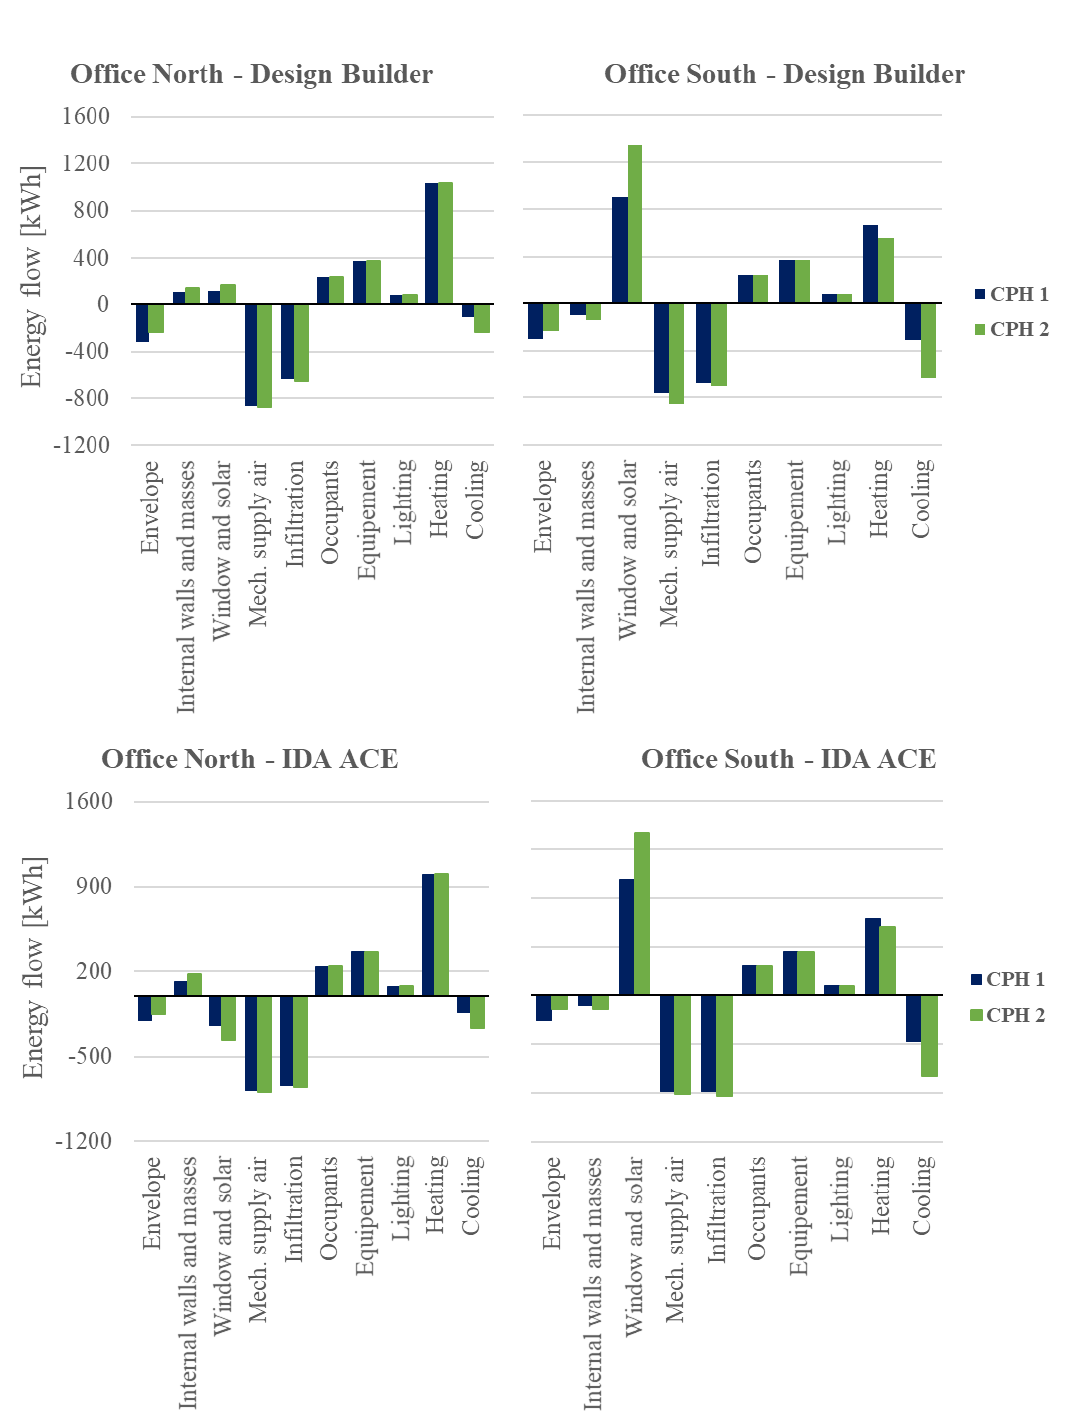
Figure 4. Energy flows for Copenhagen in Design Builder (up) and IDA ICE (down). CPH 1: Copenhagen/scenario 1, CPH 2: Copenhagen/scenario 2.